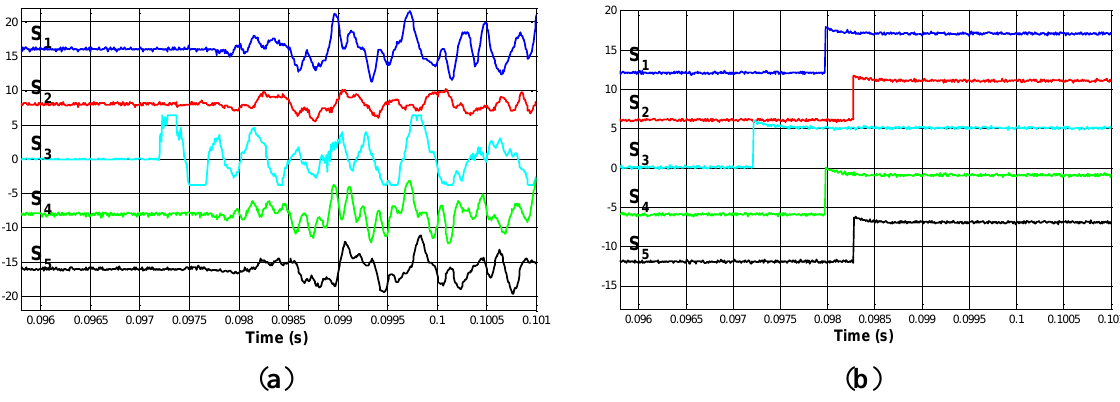
Figure 10. ( a ) Impact on 𝑃_3 . Detailed view; ( b ) Edge signals when impacting on 𝑃_3